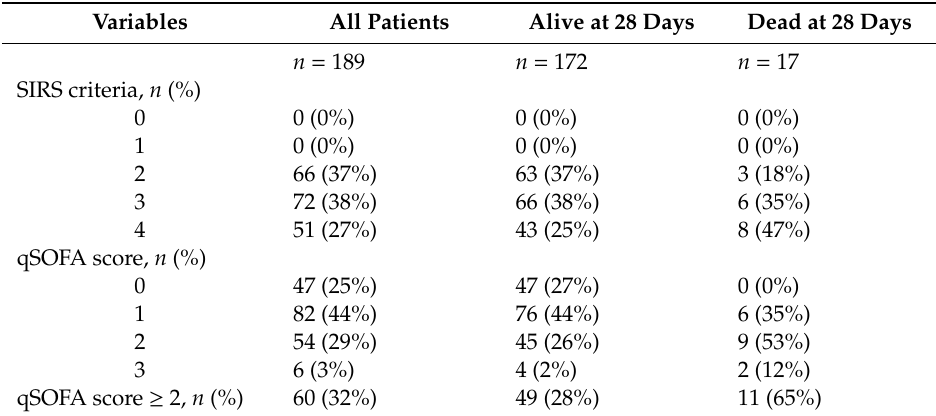
Table 2. Characteristics of patients with Staphylococcus aureus